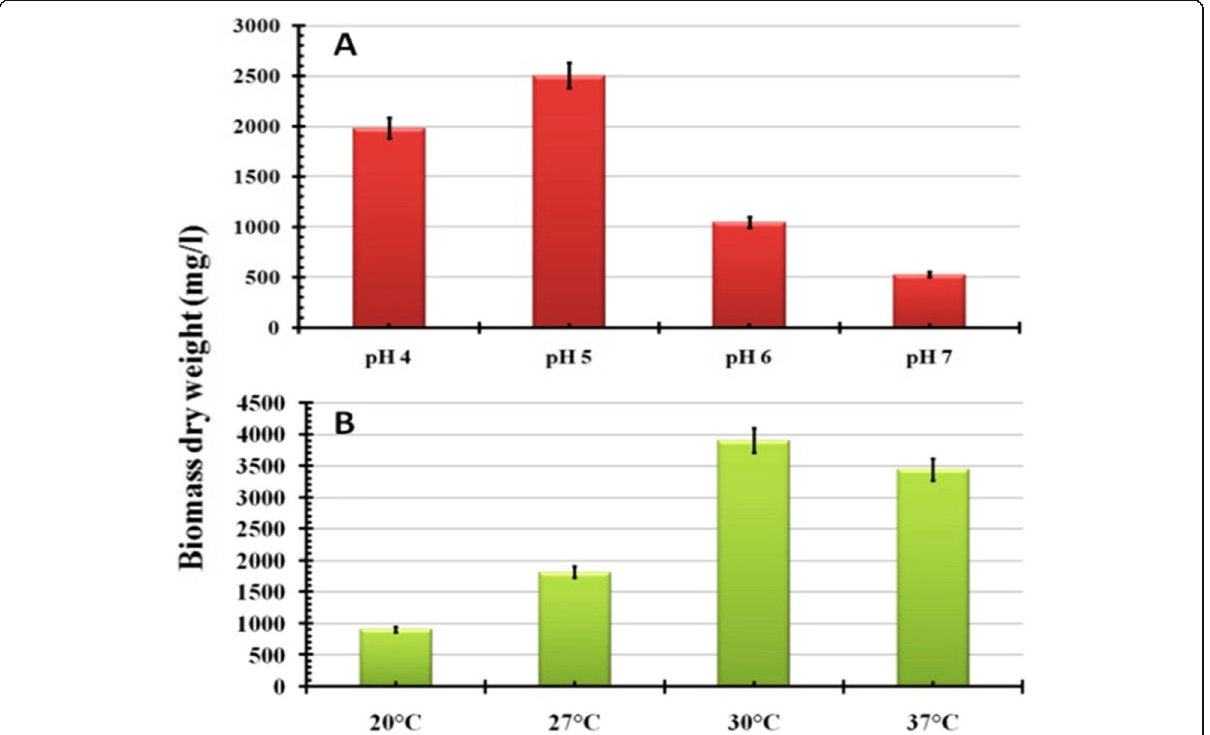
Fig. 3 Detection of the effect of culturing parameters on biomass dry weight of endophytic T. harzianum , a pH, and b incubation